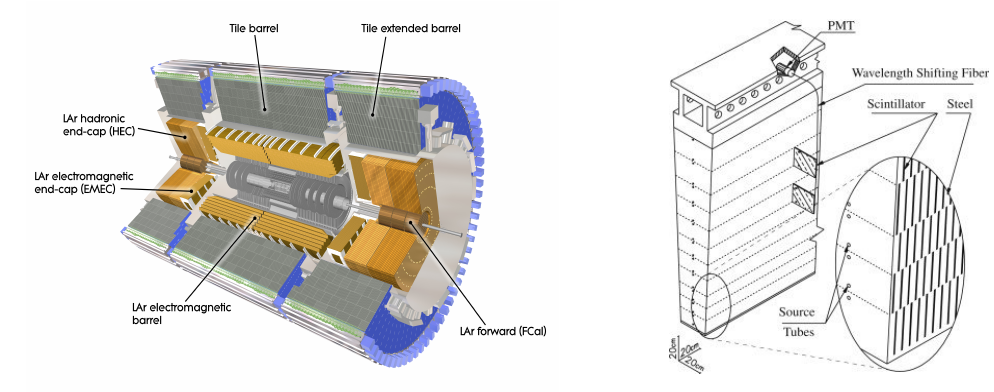
Figure 2: A computer generated image of the ATLAS calorimeter (Left) [ 4 ] . An indi- vidual module (Right) [ 3 ]